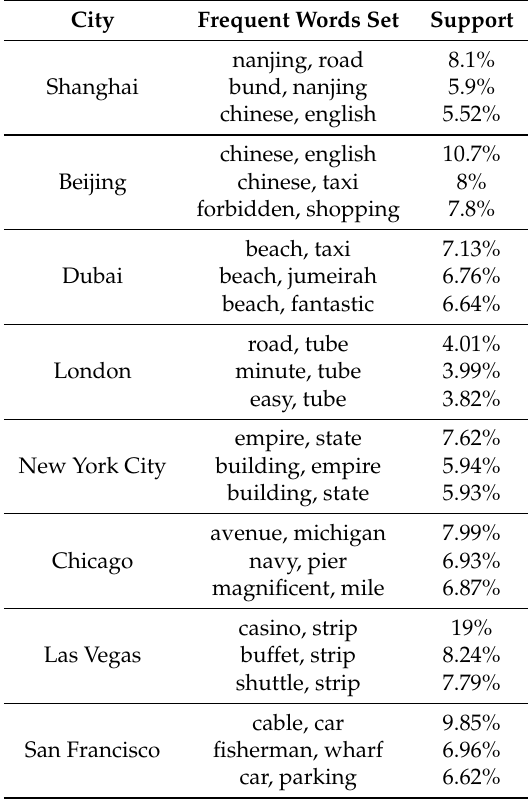
Table 4. Top three closed word-sets for each